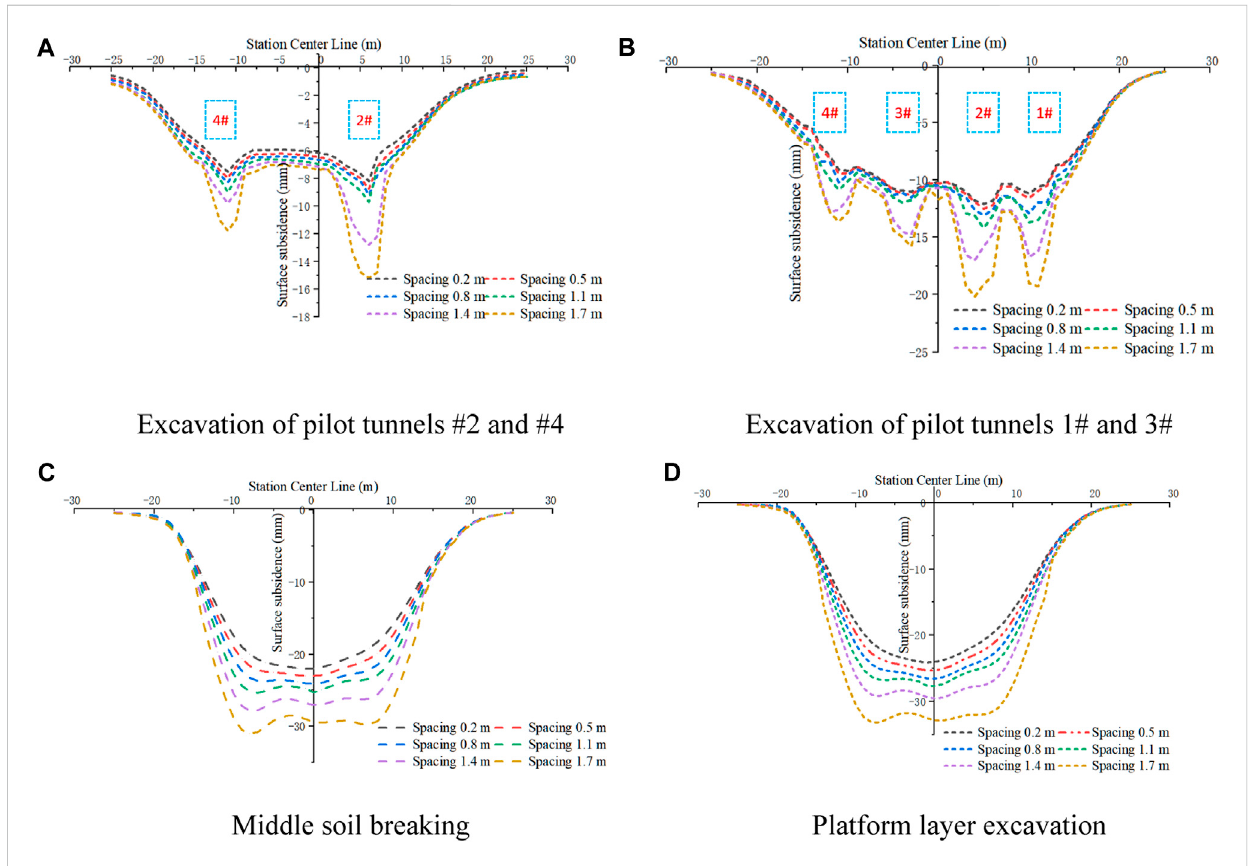
FIGURE 16 Surface subsidence curve under different pipe